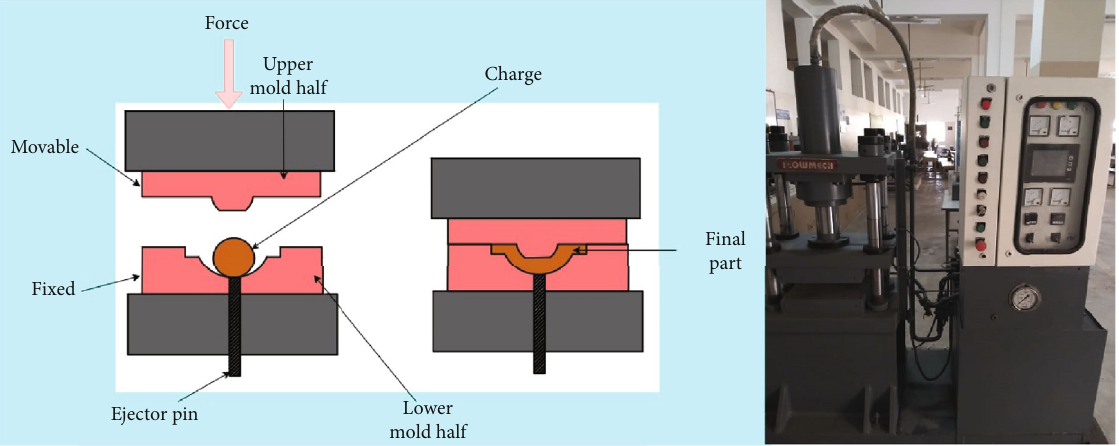
Figure 2: Compression moulding